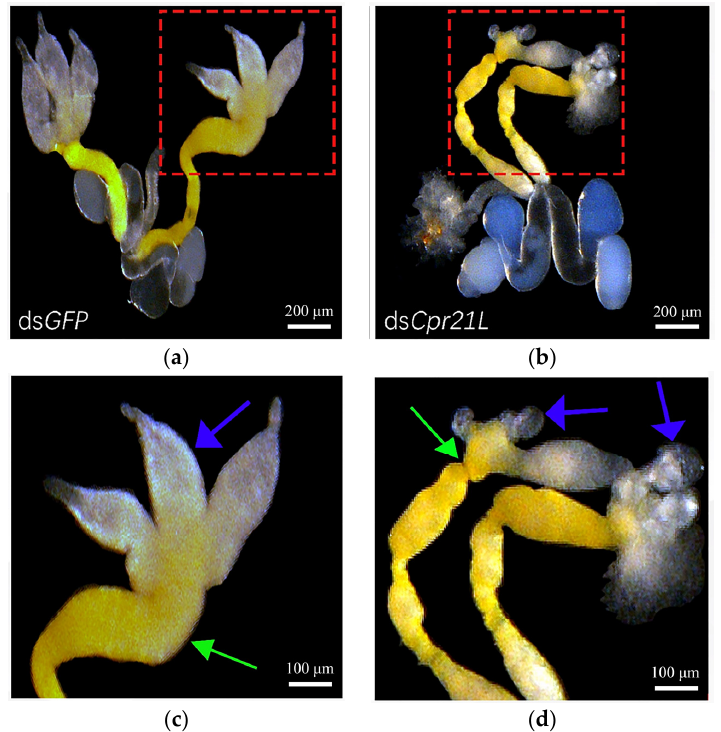
Figure 9. The effects of RNAi on the morphology of the internal reproductive organs of male adults. Newly emerged males (1–12 h) were injected with ds Cpr21L , or ds GFP (control), and 6 days later their internal reproductive organs were dissected. ( c ) and ( d ) are magnifications of the area marked with the red-dashed boxes in ( a ) and ( b ), respectively. The branches of the testes are indicated by blue arrows, and the vas deferentia are indicated by green arrows.